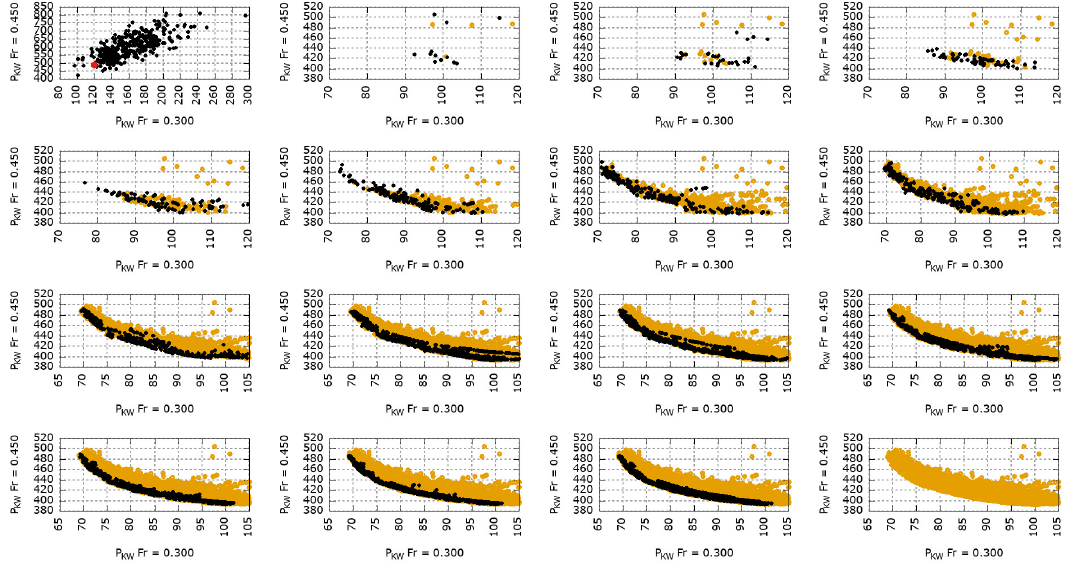
Figure 4. Evolution of the Pareto front during the iterations of the multi-objective optimization procedure of the effective power. Black dots are the newly added points after one full iteration (all the three